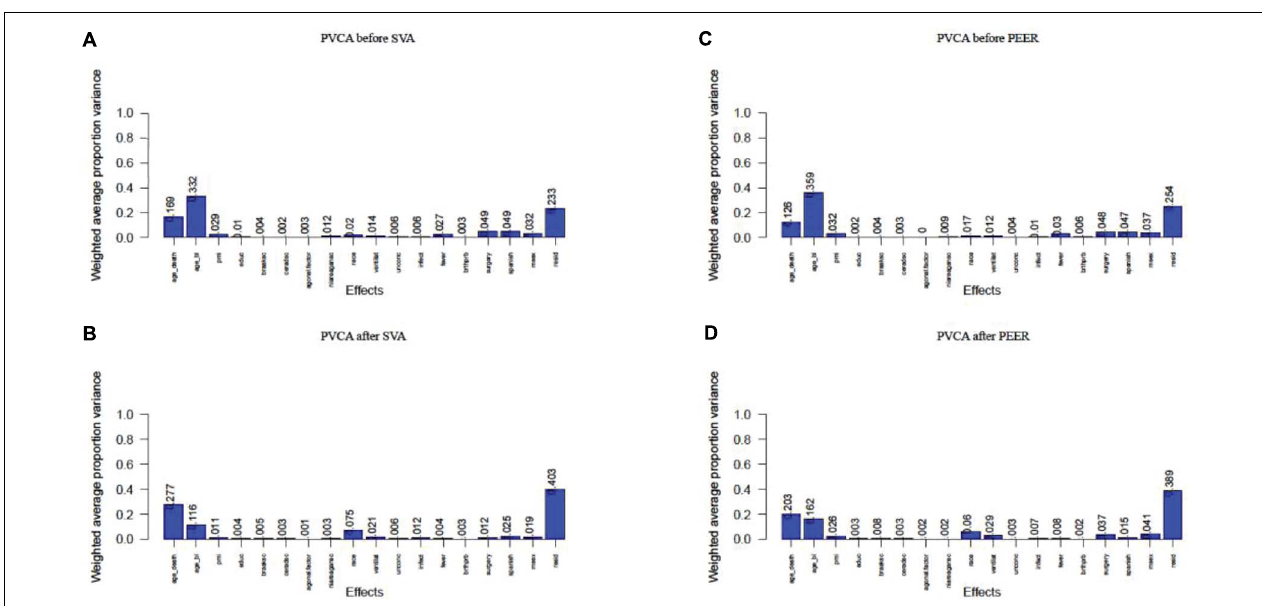
FIGURE 9 | PVCA plot of correlation before and after correction of unknown variables. (A) PVCA plot before the correction of surrogate variables; (B) PVCA plot after the correction of surrogate variables; (C) PVCA plot before the correction of hidden factors; (D) PVCA plot after the correction of hidden